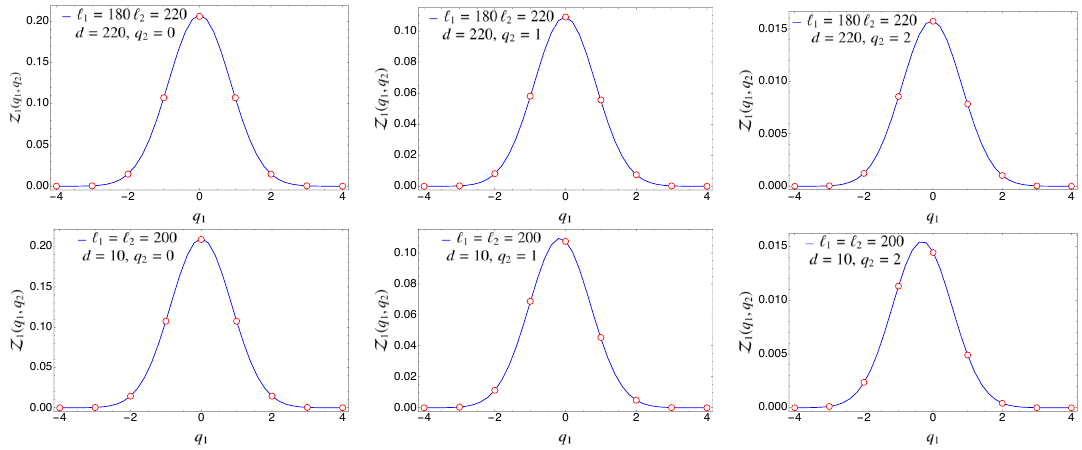
Figure 3 . Probability Z 1 ( q 1 , q 2 ) for the tight-binding model as a function of q 1 at fixed q 2 and for two disjoint intervals of lengths ‘ 1 , ‘ 2 , and separated by a distance d . The points are the exact numerical values calculated using the methods of appendix A. The solid line is the theoretical prediction in eq. (5.3) taking for the non-universal constants the corresponding values for the tight- binding model indicated in the main text.